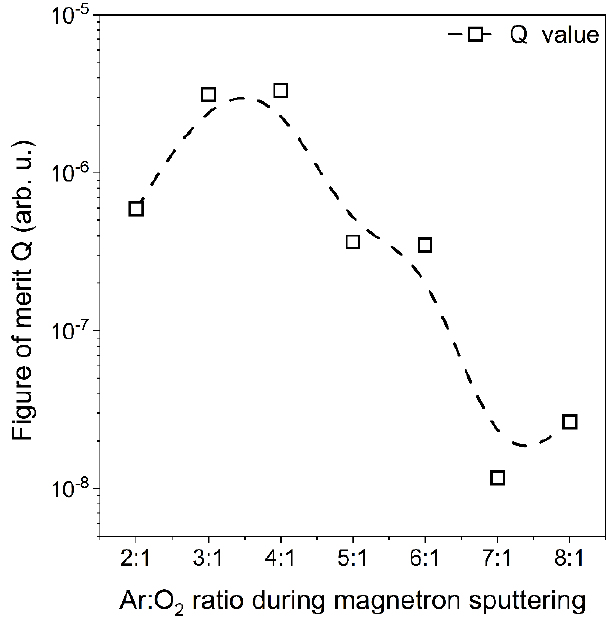
Figure 10. Dependence of the figure of merit of vanadium oxide thin films on the Ar:O 2 gas ratio during the magnetron sputtering process.